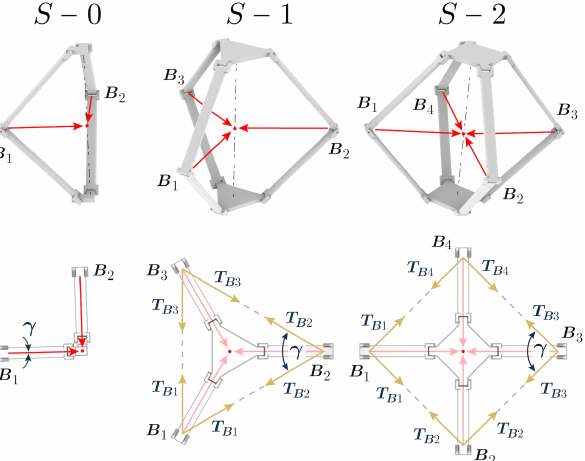
Figure 3. Family of mechanisms and tensile loadings distribution. From left to right , the classical 6-link Sarrus mechanism S 0, first dyad redundancy S − from S n possible configurations. The arrows show force vectors generating null net torque on the − revolute